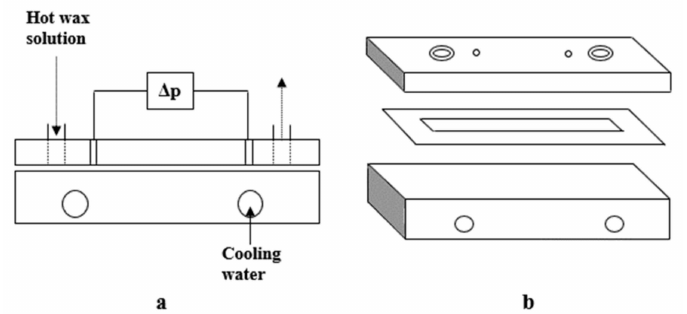
Figure 4. Schematic diagram of dynamic cold plate structure. ( a ) assembled deposition cell with direction of flow indicated by arrows, and ( b ) the upper plate, spacer and the lower plate that form the deposition channel